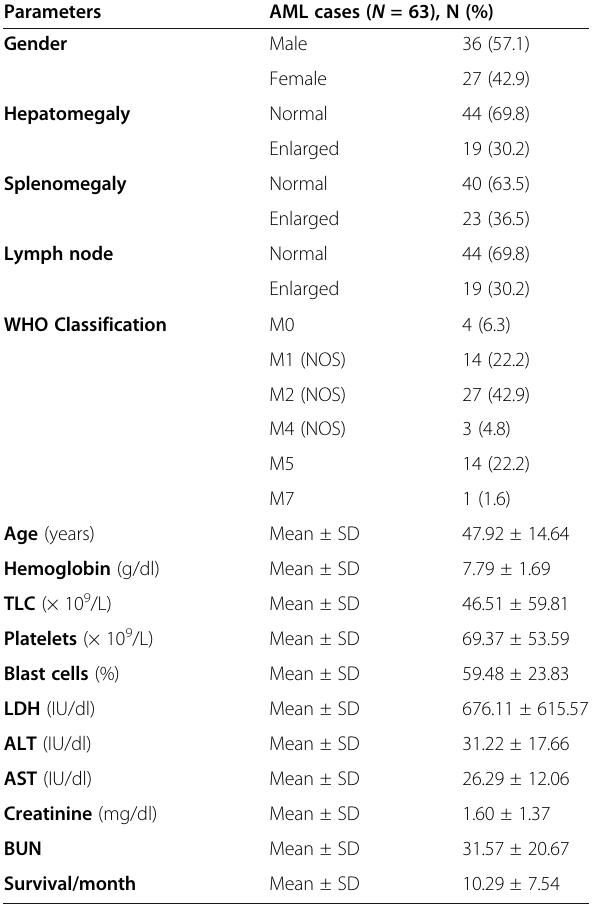
Table 1 Descriptive demographic, clinical data of 63 cases of